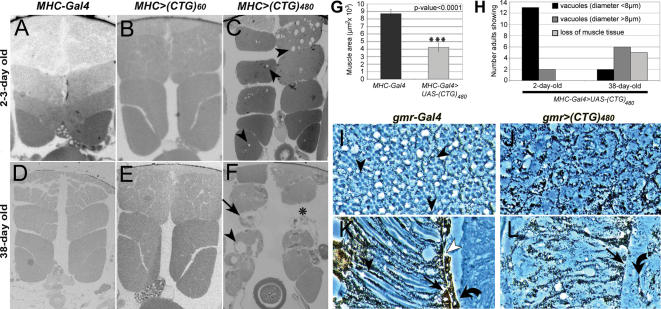
CUG-induced eye and muscle degeneration in flies.Transversal sections of resin-embedded (A–F) adult IFMs of control flies (Mhc-Gal4/+) (A, D) and flies expressing (CUG)60 (B, E) or i(CUG)480 RNA (C, F) under the control of the Mhc-Gal4 driver. IFMs were studied in 2–3-day old (A–C) or 38-day old (D–F) flies. Expression of (CUG)60 RNA was not toxic to muscle fibres (B), and IFMs did not degenerate over time (E). Expression of i(CUG)480 RNA in IFMs led to vacuolization (arrowheads) and muscle disorganization (C). Muscle degeneration and wasting was conspicuous in 38-day old flies with large vacuoles (arrowheads), lower density of myofibrils per muscle (arrow) and missing muscles (asterisk). Results consistent with these have been obtained independently [5]. (G) Cross-sectional area of left dorso longitudinal muscle 45e [51] in 2 day-old control (Mhc-Gal4/+) and DM1 model flies (Mhc-Gal4>UAS-i(CTG)480). n = 12 (control) and n = 34 (CUG expressing). (H) Muscle degeneration was measured as the frequency of vacuolar pathology and muscle area reduction, according to the following rating scale: vacuoles with diameter larger or smaller than 8 µm, or showing 45% or less of the normal muscle area. Muscle 45e was measured in 3-4 thorax sections per animal and a total of 15 young (2-day-old) or 13 aged (38-day-old) flies were analyzed. Control (Mhc-Gal4/+) and Mhc-Gal4>UAS-(CTG)60 flies showed no muscle phenotype 2 or 38 days after eclosion. Tangential (I, J) and frontal (K, L) sections of adult Drosophila eyes with the genotypes gmr-Gal4/+ (I, K) and gmr-Gal4/UAS-i(CUG)480 (J, L) at 25°C. (I) Tangential sections exhibited a normal complement of photoreceptors per ommatidial unit (arrowheads point to rhabdomeres), although some pigment cells were absent. (J) Expression of expanded CUG repeats caused general disorganization of the eye retina. (K) In controls, rhabdomeres extend from the apical to the basal side of the retina (arrowheads) and the layer of pigment cell feet forms the fenestrated membrane (arrow), which is separated by the basement membrane (white arrowhead) from the underlying subretinal cells (bent arrow). (L) Eyes expressing i(CUG)480 RNA lacked rhabdomeres and showed general disorganization of pigment cells. Fenestrated membranes were thinner and showed gaps (arrow). Subretinal cells were not tightly apposed to the basement membrane (bent arrow).